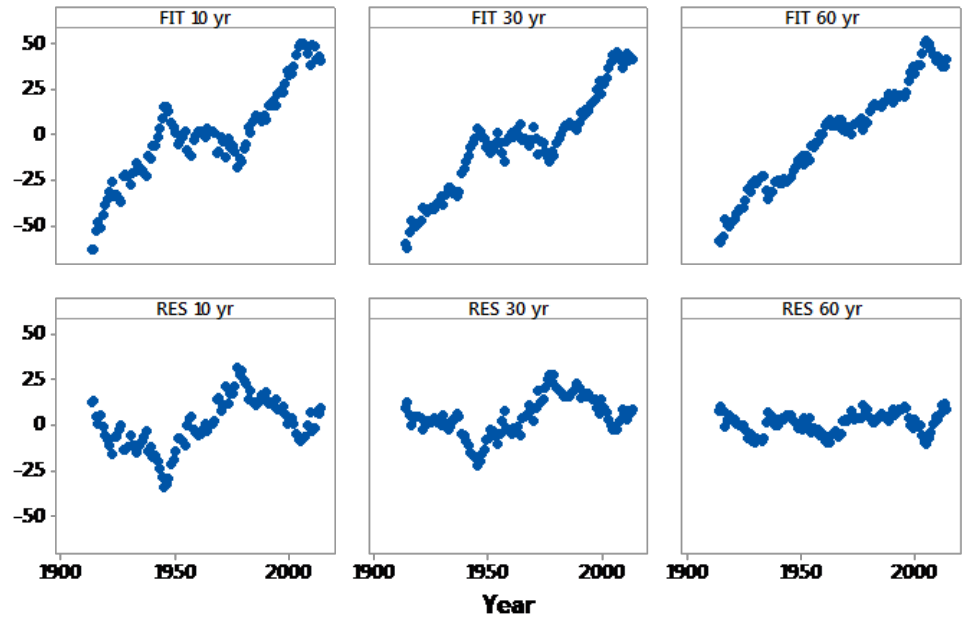
Figure 6: Reconstructed (fits) synthetic sea level trend (1 mm/yr) and its corresponding residuals from three distributed lag model solutions with 10, 30, and 60 yr lag-lengths.